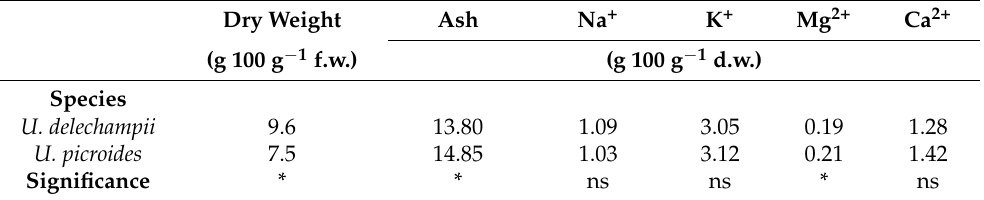
Table 4. Ash and cation content of wild smooth golden fleece ( U. delechampii ) and prickly golden fleece ( U. picroides ) gathered in